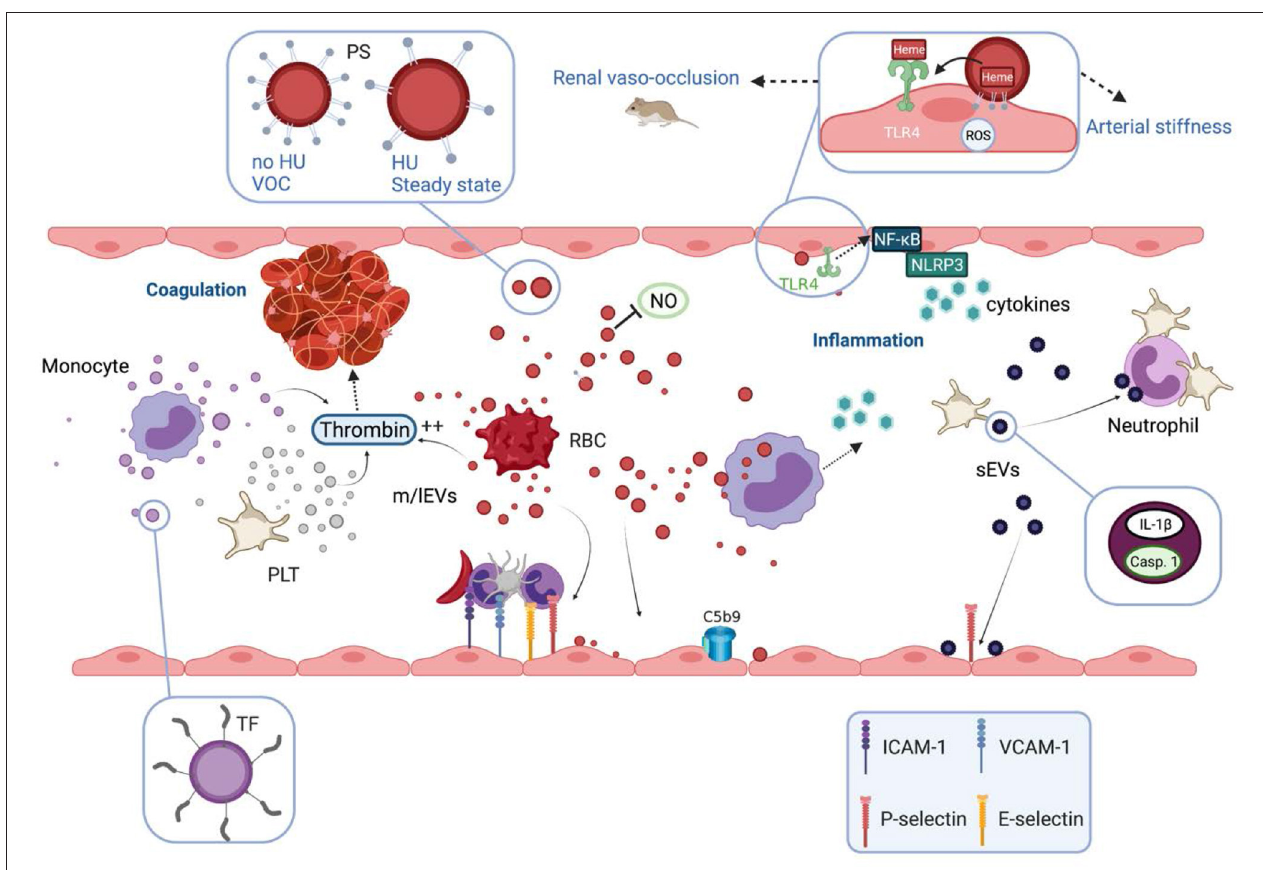
FIGURE 2 | Biological properties and pathophysiological consequences of extracellular vesicles in sickle cell disease. Extracellular vesicles (EVs) partly cause the hypercoagulant and prothrombotic state known in sickle cell disease (SCD). m/lEVs generated in vitro from stimulated monocytes, RBCs or platelets are able to trigger thrombin generation through TF-dependent and TF-independent mechanisms. Intrinsic coagulation pathway activation by RBC- and platelet-derived m/lEVs relies on the exposure of phosphatidylserine at their outer membrane leaflet. EVs also contribute to the inflammatory state of SCD patients. m/lEVs produced in vitro from sickle RBCs can be internalized by monocytes leading to the secretion of several proinflammatory cytokines and can increase the adhesion of monocytes to the endothelium. m/lEVs generated in vitro by sickle RBCs have been shown to promote renal vaso-occlusion in sickle cell mice and to induce endothelial cell apoptosis and ROS production. The high level of PS exposed at the surface of these vesicles, as well as their content in heme, could play a role in their deleterious effects on the vascular function. RBC-m/lEVs directly isolated from SCD patients’ blood samples, promote the expression of adhesion molecules (ICAM-1, E-Selectin) and the production of pro-inflammatory cytokines by cultured endothelial cells. The endothelial activation mediated by these EVs involves the TLR4 signaling pathway. These proinflammatory properties are considerably reduced for m/lEVs obtained from patients treated with HU, which exhibit low PS externalization. In contrast, m/lEVs collected from patients during vaso-occlusive crisis exhibit high PS exposure and have deleterious effects on endothelial cells. RBC-m/lEVs could decrease NO bioavailability through their scavenging effects. In addition, both externalized PS and heme exposed by RBC-derived m/lEVs obtained using a calcium ionophore, have been shown to activate complement system on endothelial cell membranes. In humanized SCD mice, the stimulation of platelets leads to the release of sEVs highly loaded with IL-1 β and caspase-1, which bind to neutrophils and promote platelet-neutrophil aggregation. VOC, vaso-occlusive crisis; NO, nitric oxide; ROS, reactive oxygen species; HU, hydroxyurea; PS, phosphatidylserine; TF, tissue factor; TLR4, toll like receptor 4; Casp.1, caspase 1; PLT, platelets; RBC, red blood